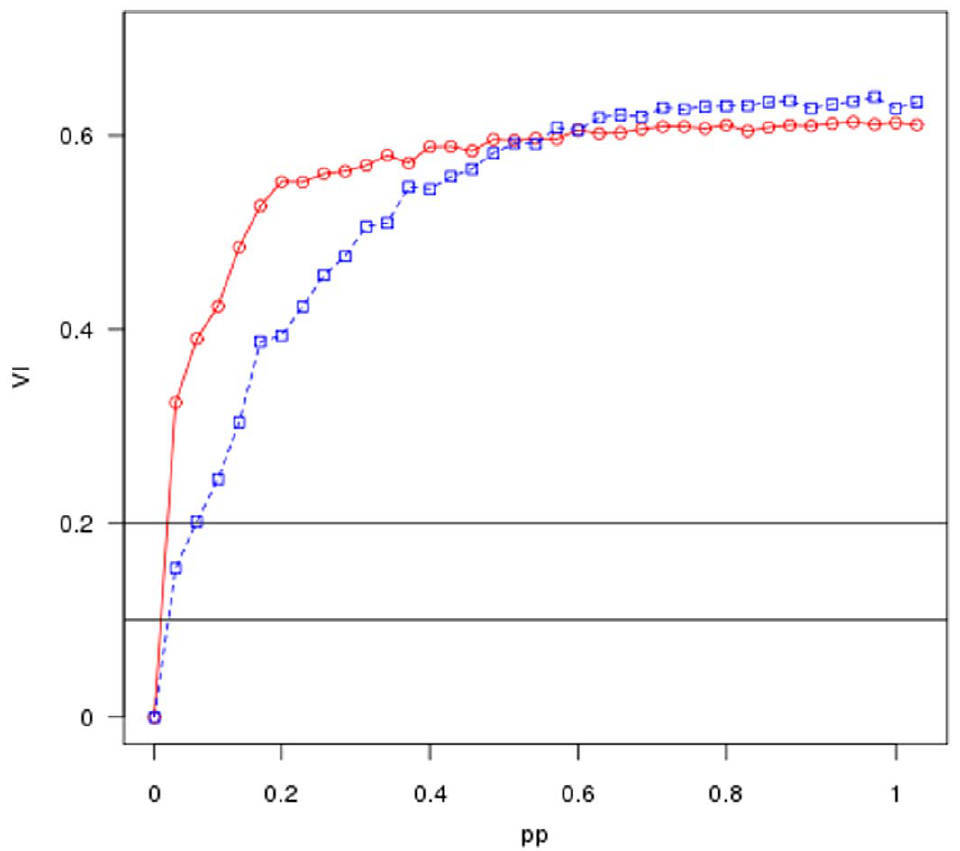
Figure 4. Average results of the application of our stability analysis to the real Biological data example. The average value of the normalized variation of information is plotted as a function of the amount of perturbation pp . The black points in the figures show the variation of information for the unperturbed biological network while the red points show the results for the correspondent random graph (null model).